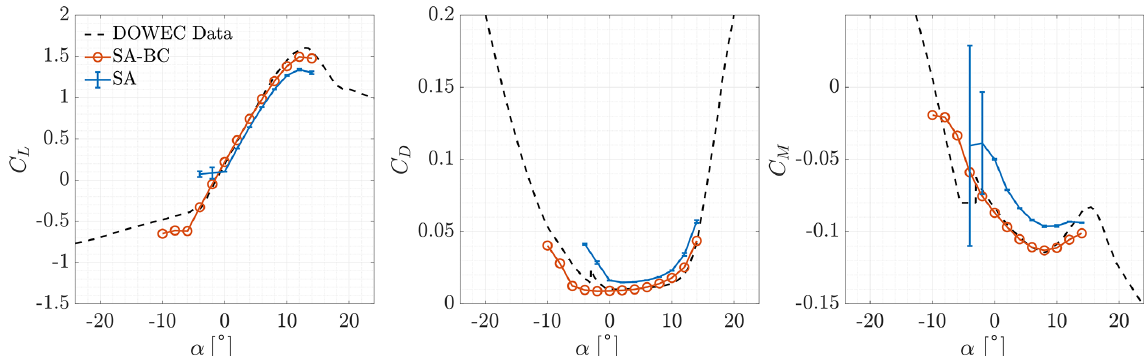
Figure 9. Aerodynamic coefficients of the DU35 airfoil.